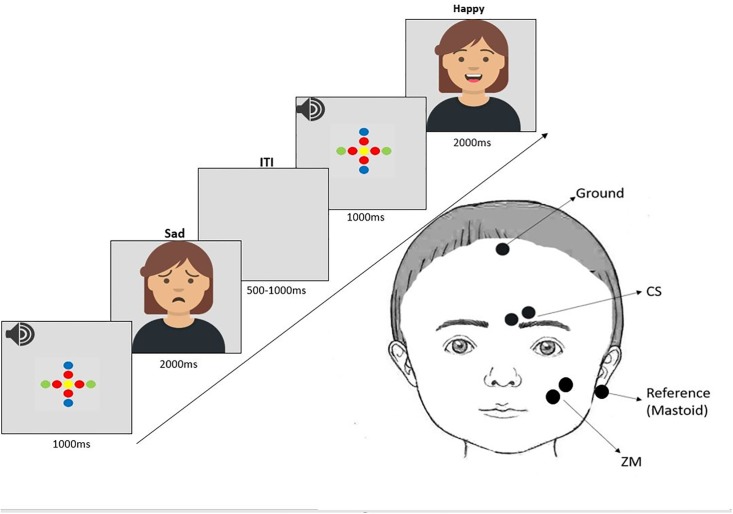
Study design and EMG paradigm.Study design illustrating the trials presentation during facial electromyographic (EMG) recordings over the zygomaticus major muscle (smiling) and the corrugator supercilii muscle (frowning). The example stimuli are not the original images used in the study, due to copyright license of the stimuli from the Radboud Faces Database. The avataars were created and used here for illustrative purposes only (https://getavataaars.com).